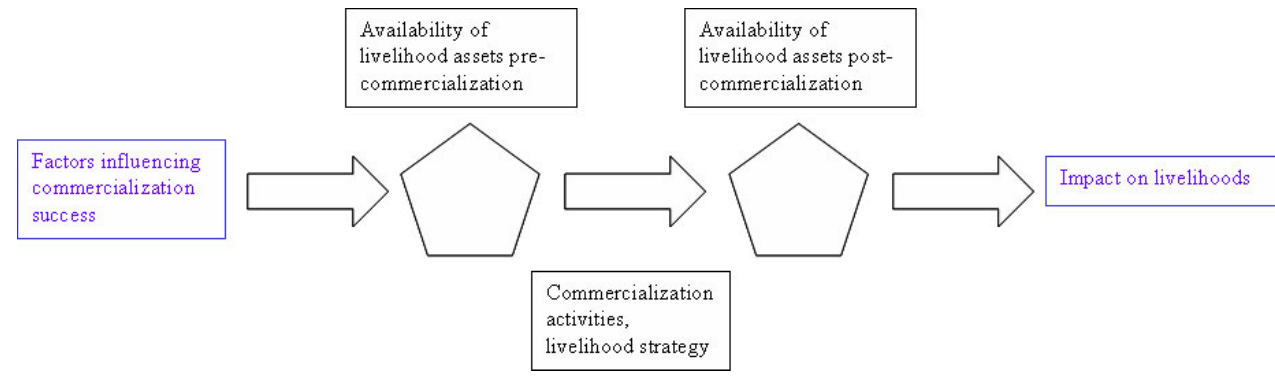
Fig. 1. Analytical framework for assessing the impact of NTFP commercialization on